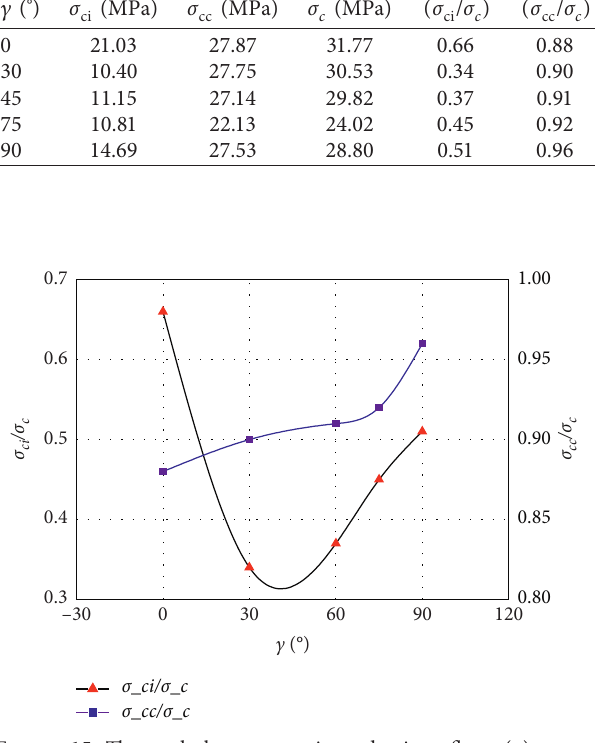
/ σ c ) and ( σ / σ c ) ci cc